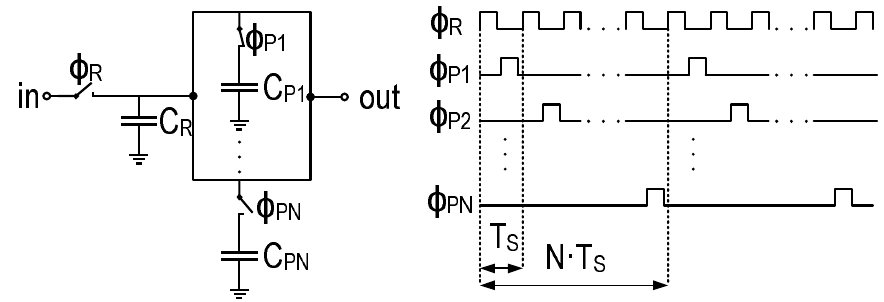
Figure 8. Simplified schematic of the passive switched-capacitor (SC) N-path filter with its timing diagram.